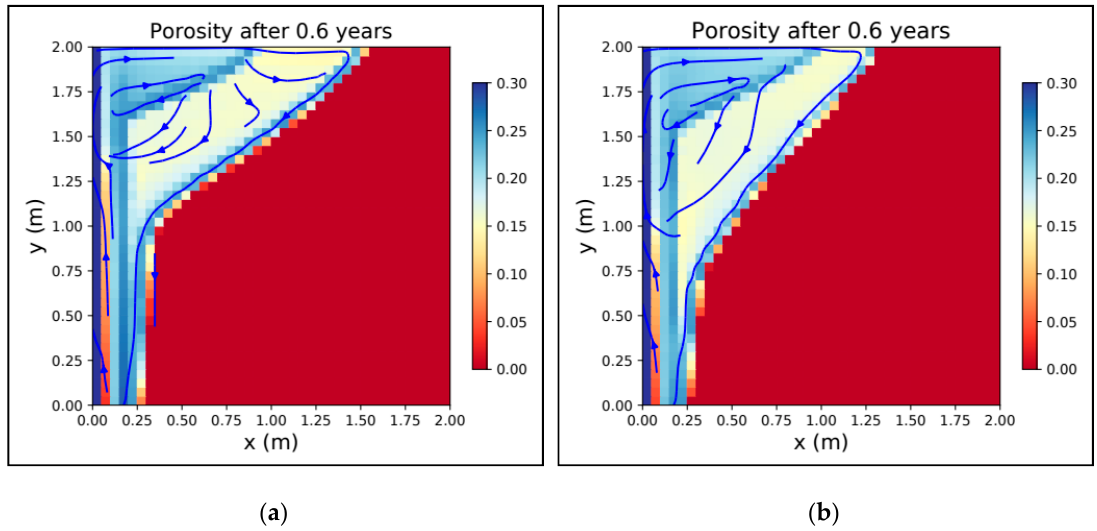
Figure 12. Porosity distribution in a transport- and advection-dominated system with 20 wt.% carnallite and a dissolution rate of ( a ) 10 − 3 cm/s and ( b ) 10 − 4 cm/s.